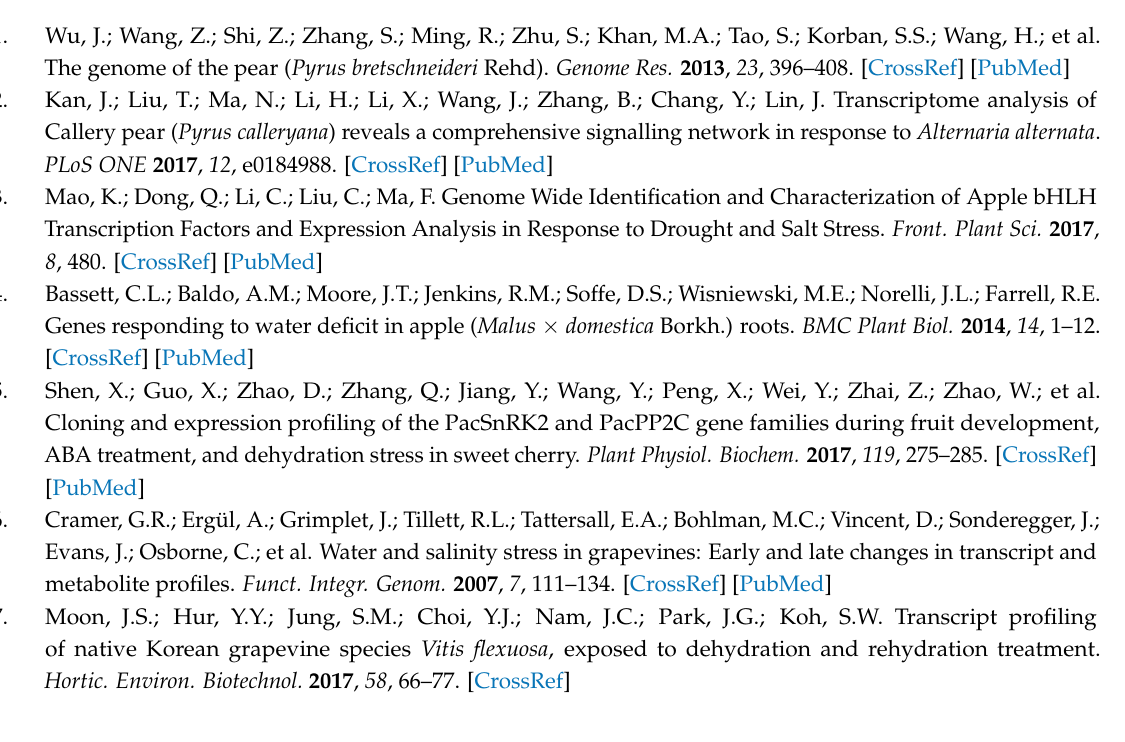
Supplementary Materials: The following are available online at http://www.mdpi.com/2073-4425/9/6/311/ s1, File S1. The 14,478 lncRNA sequences obtained by RNA sequencing of Pyrus betulifolia in control and drought stressed conditions. Table S1. Sequence of the primers used in qRT-PCR analysis. Table S2. The family classify of lncRNA of Pyrus betulifolia obtained from drought stress condition. Table S3. lncRNA target precursors for miRNA in Pyrus betulifolia under drought stressed conditions. Table S4. The significantly different expressed lncRNAs between 24 h and 48 h compared to 0 h of Pyrus betulifolia under drought stress. Table S5. Gene Ontology (GO) of putative target genes of differentially expressed lncRNA of 24 h vs. 0 h based on coexpression. Table S6. Gene Ontology(GO) of putative target genes of differentially expressed lncRNA of 48 h vs. 0 h based on coexpression. Table S7. KEGG enrichment result of putative target genes of differentially expressed lncRNA of 24 h vs. 0 h based on coexpressionTable S8. KEGG enrichment result putative target genes of differentially expressed lncRNA of 48 h vs. 0 h based on coexpression. Table S9. Gene Ontology(GO) of putative target genes of differentially expressed lncRNA of 24 h vs. 0 h base on colocation. Table S10. Gene Ontology(GO) of putative target genes of differentially expressed lncRNA of 48 h vs. 0 h base on colocation. Table S11. KEGG enrichment result of putative target genes of differentially expressed lncRNA of 24 h vs. 0 h base on colocation. Table S12. KEGG enrichment result of putative target genes of differentially expressed lncRNA of 48 h vs. 0 h base on colocation. Table S13. lncRNA and their putative target mRNA based on the coexpression results. Table S14. lncRNA and their putative target mRNA based on the colocation results. Table S15. Relative expression data measured by qRT-PCRs and RNAseq. Figure S1. The genome browser with read coverage of the lncRNA7695 and